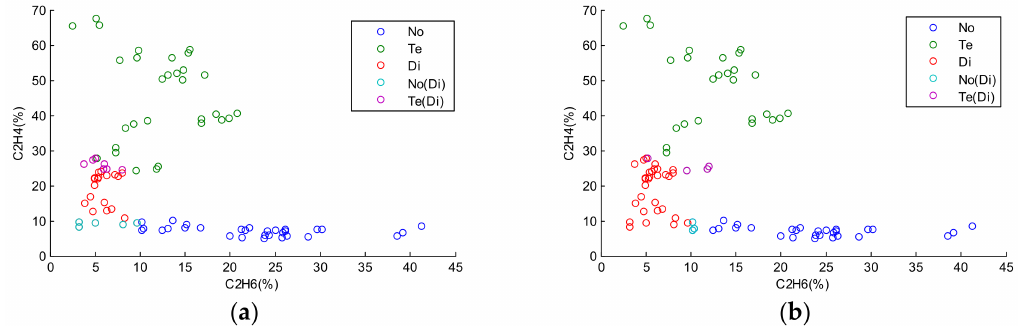
Figure 4. Classification results by different approaches: ( a ) Classification result by regularized ELM with mean imputation (MI) (Re = 12.2%); ( b ) Classification result by regularized ELM with K-nearest neighbor imputation (KNNI) (Re = 6.67%).